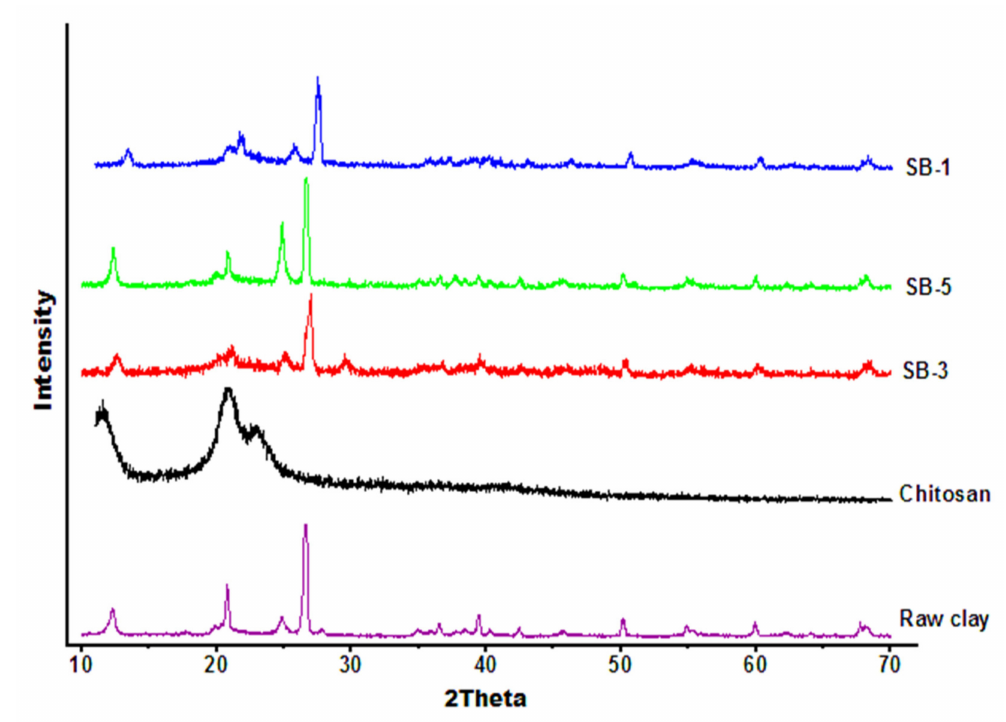
Figure 3. Comparison of XRD data of raw clay, chitosan, and composites (SB-1, SB-3, and SB-5).